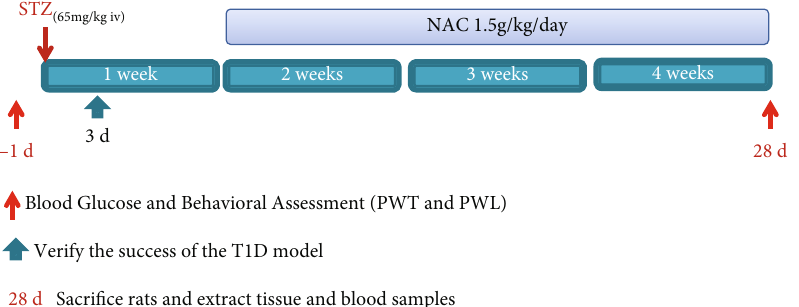
Figure 1: Schematic and timeline of the experimental design. PWT =paw withdrawal threshold; PWL =paw withdrawal